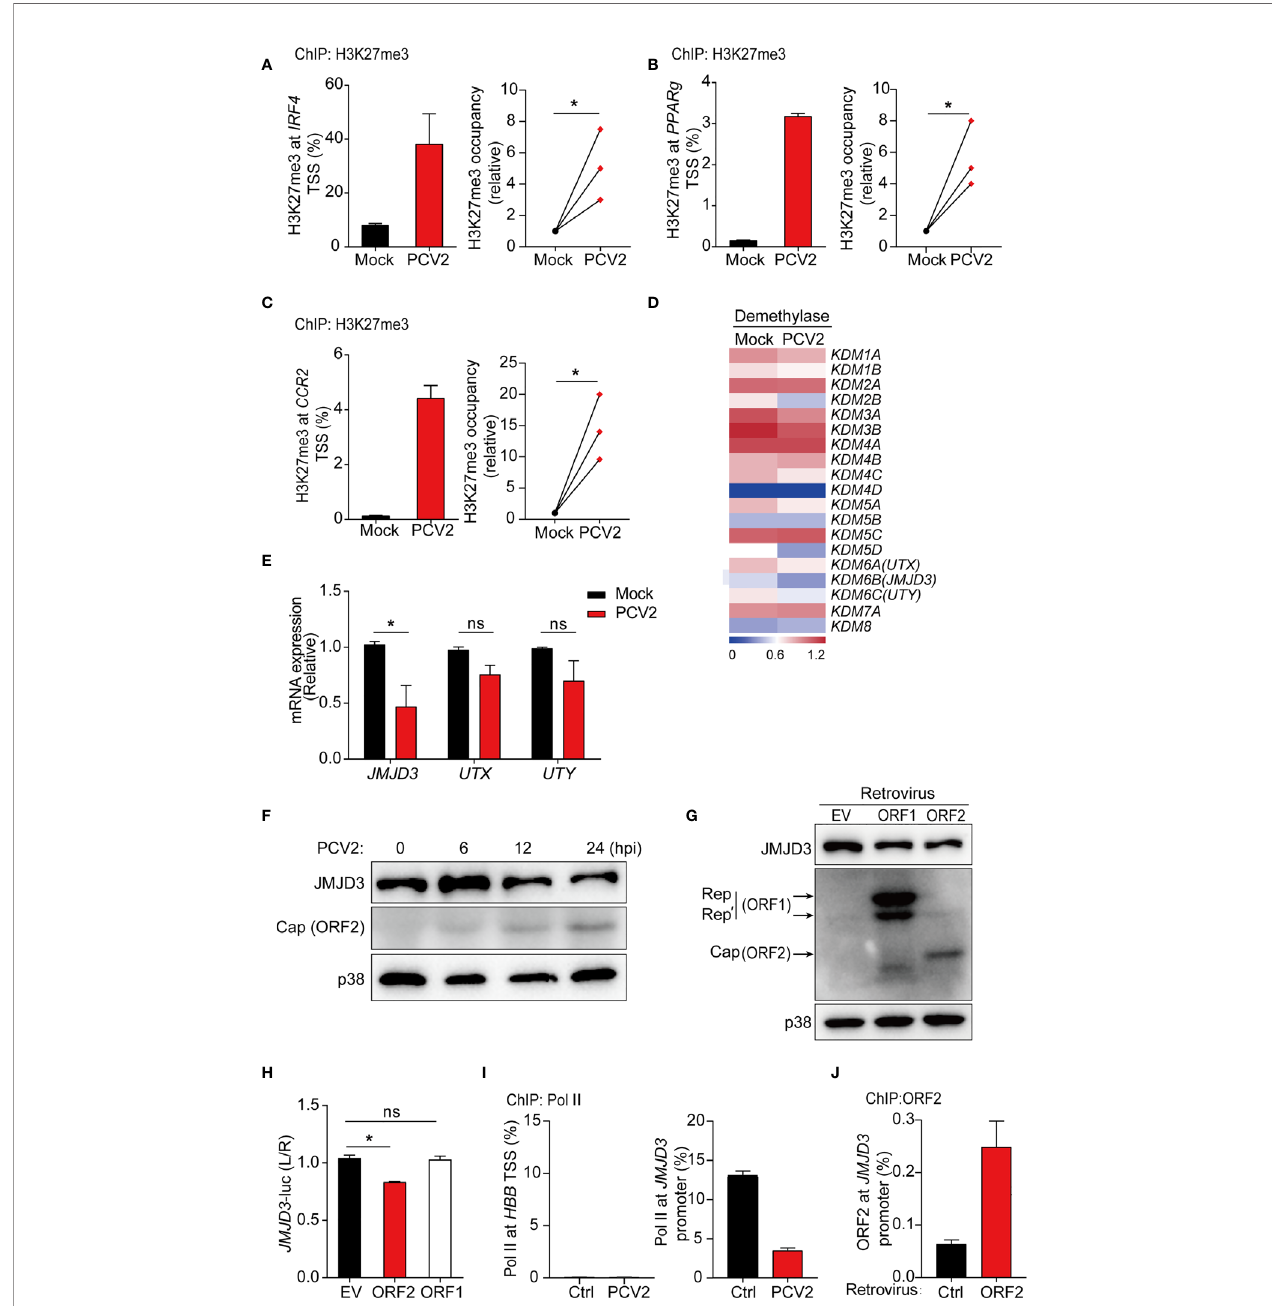
FIGURE 4 | PCV2 enhances H3K27 trimethylation to suppress M2-associated gene expression. (A – C) ChIP analysis of H3K27me3 occupancy at the promoter regions of IRF4 (A) , PPARg (B) and CCR2 (C) in BMDMs left untreated or infected with PCV2 (0.02 MOI, the same dose below) for 12 h, and cumulative results ( A – C , right) for H3K27me3 at IRF4, PPARg or CCR2 under PCV2-infected conditions, presented relative to results obtained from control cells, set as 1. (D, E) Heatmap of gene expression pro fi les of 19 histone demethylases (D) or qPCR analysis of mRNA expression of KDM6 family members ( JMJD3, UTX, UTY ) (E) in BMDMs left untreated or infected with PCV2 for 12 h. (F, G) Immunoblot analysis of JMJD3, Cap and/or Rep of PCV2 in BMDMs infected with PCV2 for various times at 6, 12 or 24 hours (F) or transduced with control empty vector, PCV2 ORF1 (Rep) or ORF2 (Cap)-encoding retrovirus (G) . p38 served as a loading control. (H) Luciferase activities in HEK293T cells co-transfected with a JMJD3 promoter-driven reporter construct and ORF1 or ORF2 expression plasmid or control empty vector. Twenty-four hours after transfection, cell lysates were analyzed for luciferase activity. (I, J) ChIP analysis of Pol II occupancy (I) or PCV2 Cap (ORF2) occupancy (J) at the promoter of JMJD3 (right) or the silent locus encoding hemoglobin- b ( HBB ) (left) in BMDMs left untreated or infected with PCV2 for 12 h or BMDMs transduced with control retroviruses or retroviruses expressing PCV2 ORF2 (myc tag). Data are representative from one ( D, G, J ; mean + s.d. of technical triplicates in J ), two ( F, I ; mean + s.d. of technical triplicates in I) or three ( A – C , mean + s.d. of technical triplicates in A – C left) independent experiments or pooled from three ( A – C right, E, H ; mean + s.d) independent experiments. ns, not signi fi cant; * P < 0.05 (Student ’ s t